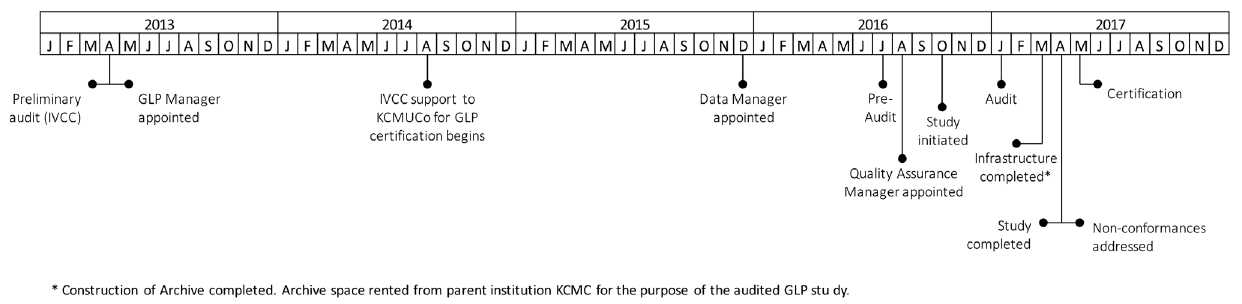
Figure 2. Timeline of GLP certification at the test facility. Key events related to GLP certification at the test facility between 2013 and 2017 were mapped on a timeline. The majority of key events were in late 2016/early 2017.